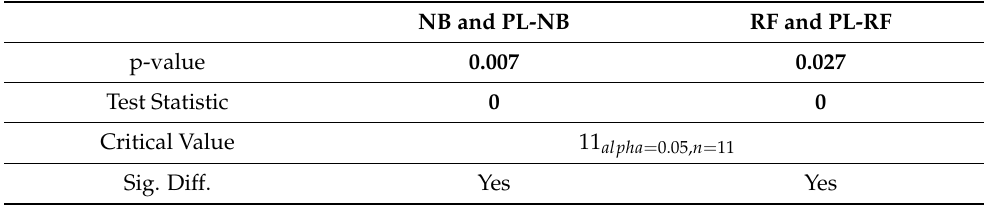
Table 10. Wilcoxon hypothesis test